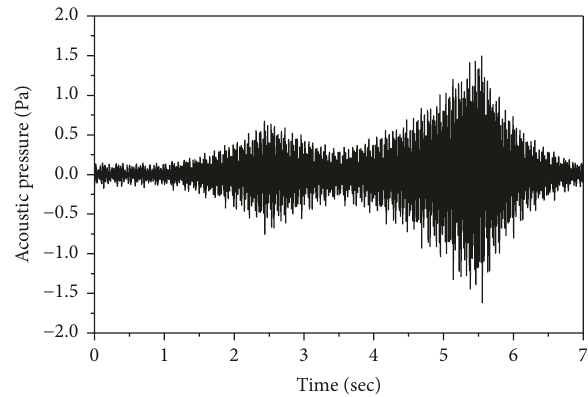
Figure 8: Acoustic pressure variation due to rpm change of stimuli used in the auditory experiment.